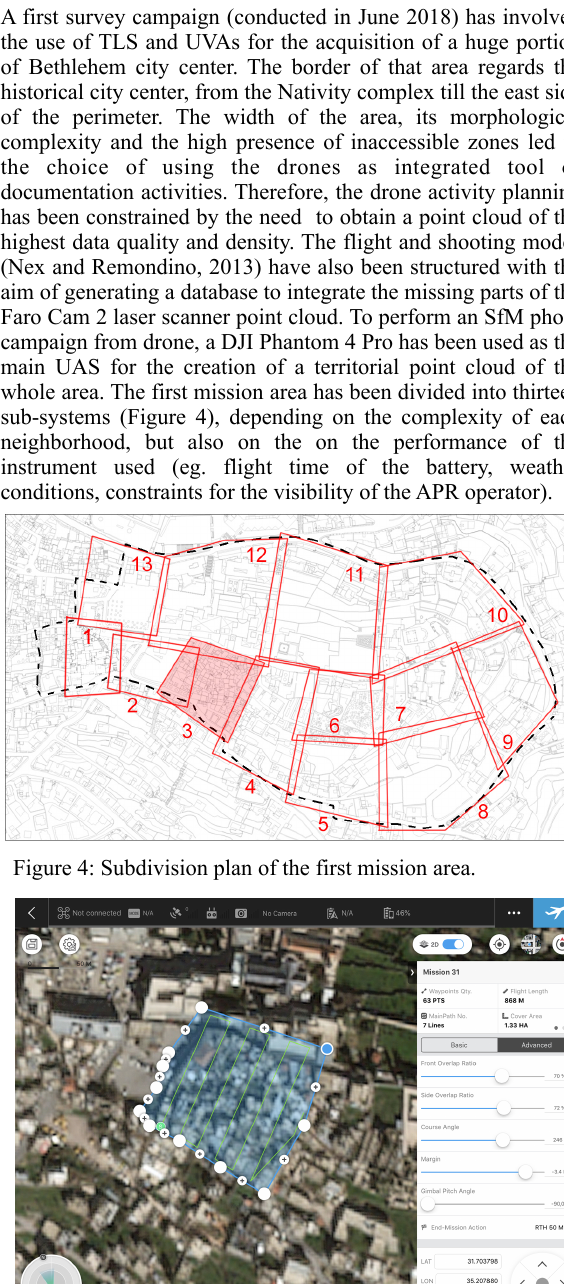
Figure 7: The Agisoft Photoscan visualization of the total 3D model in wireframe and texture mode obtained by DJI Phantom 4 Pro flight